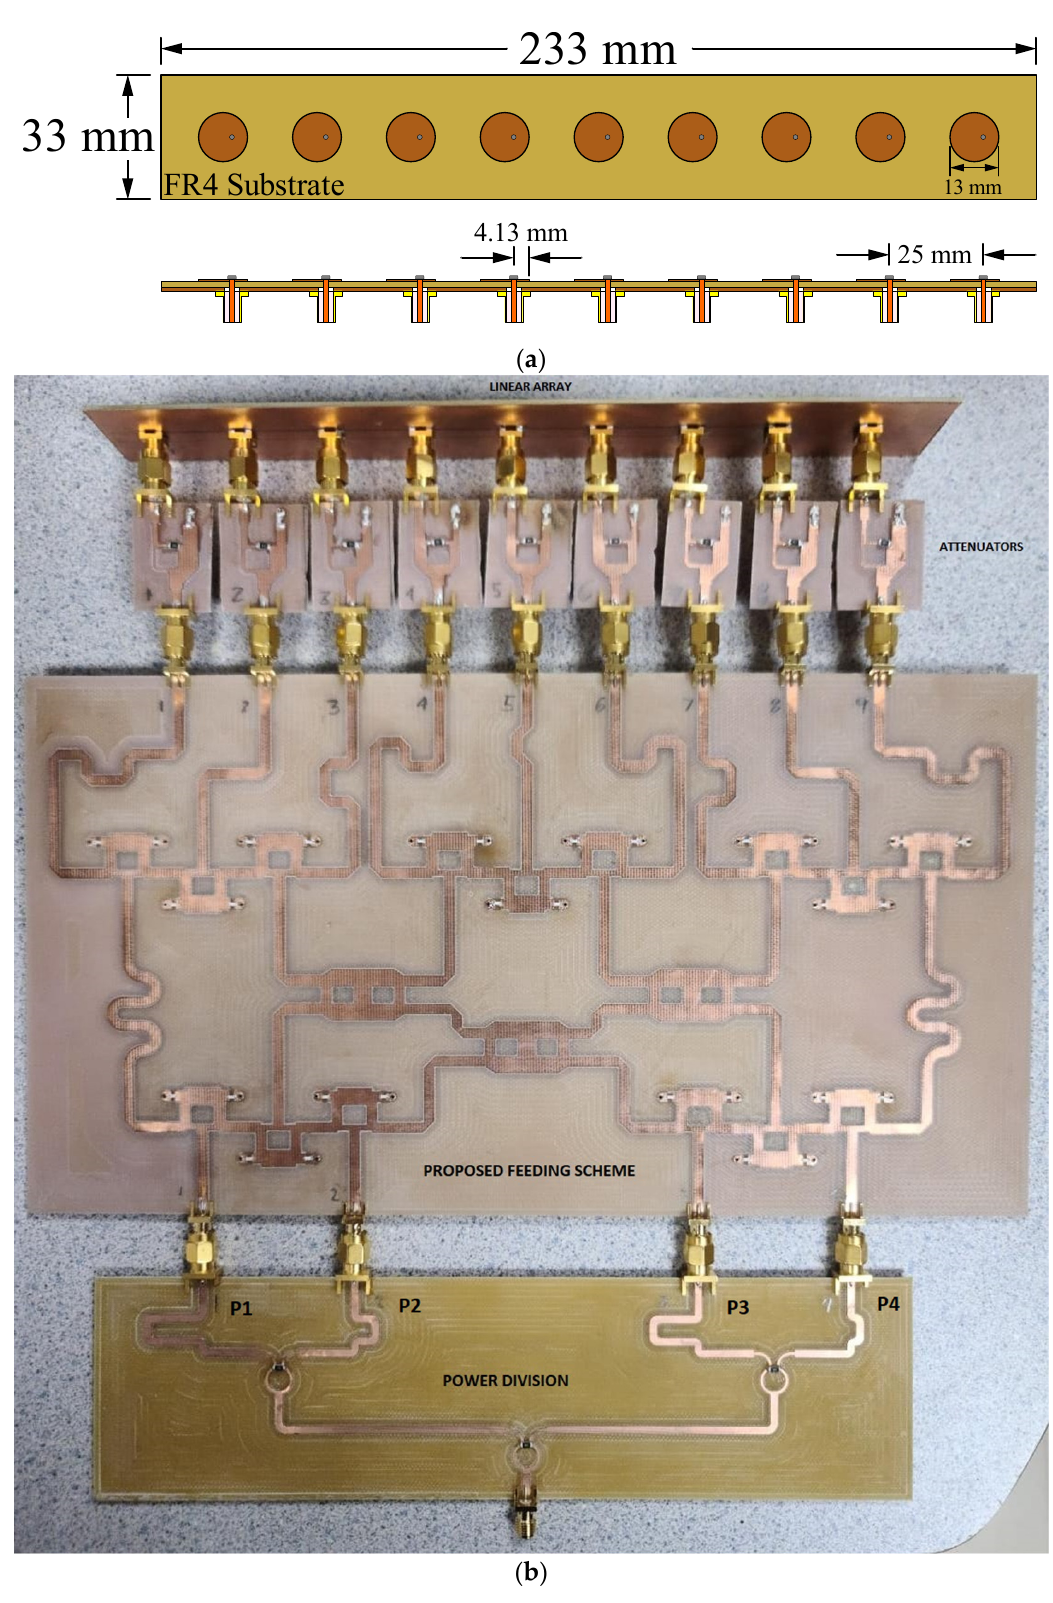
Figure 9. Linear phased array, ( a ) antenna elements configuration, and ( b ) the fabricated prototype of the complete system with power values of approximately 15 dBm, and phase shift values of (0 ◦ , 152.14 ◦ , 96.42 ◦ , 248.57 ◦ ) for P 1 , P 2 , P 3 and P 4